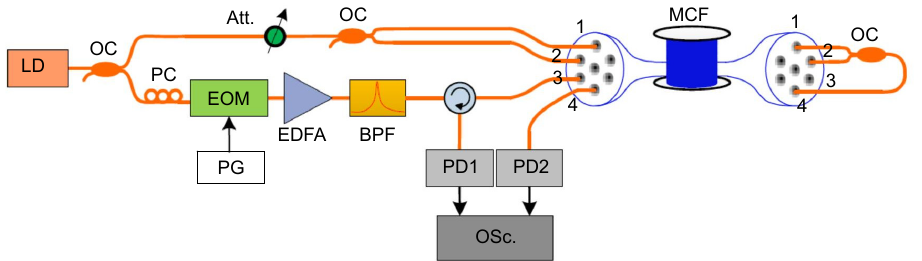
Fig. 16 | Experimental setup for the SDM reflectometer and interferometer hybrid sensor. LD: Laser diode; OC: optical coupler; PC: polari- zation controller; Att.: tunable attenuator; EOM: electro-optic modulator; PG: pulse generator; EDFA: erbium-doped fiber amplifier; BPF: band-pass filter; PD: photodetector; OSc.: oscilloscope. Figure reproduced from ref. 63 , IEEE.